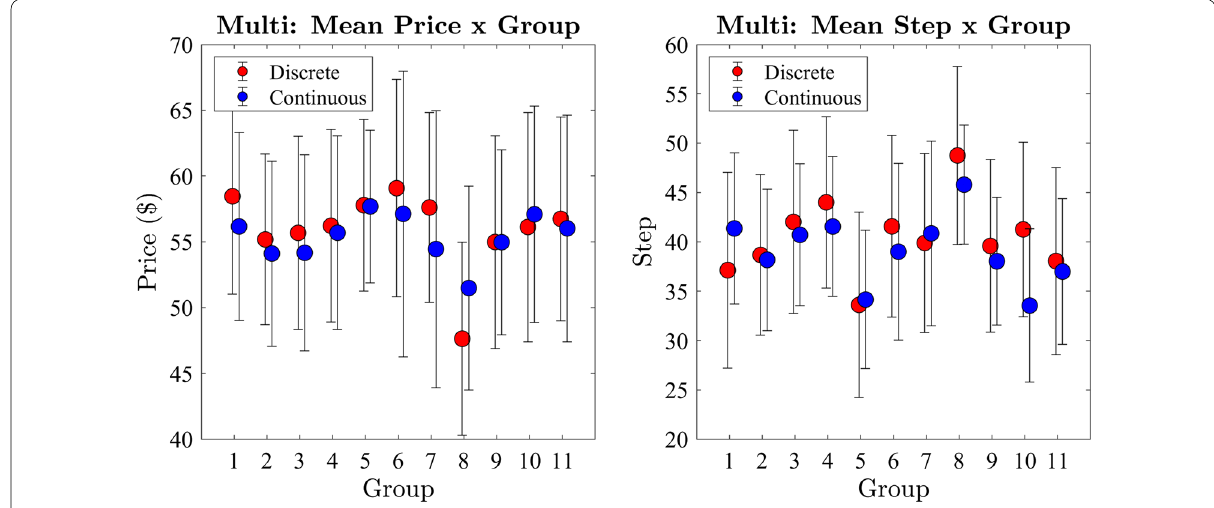
Fig. 10 Exp 2: mean price and step per